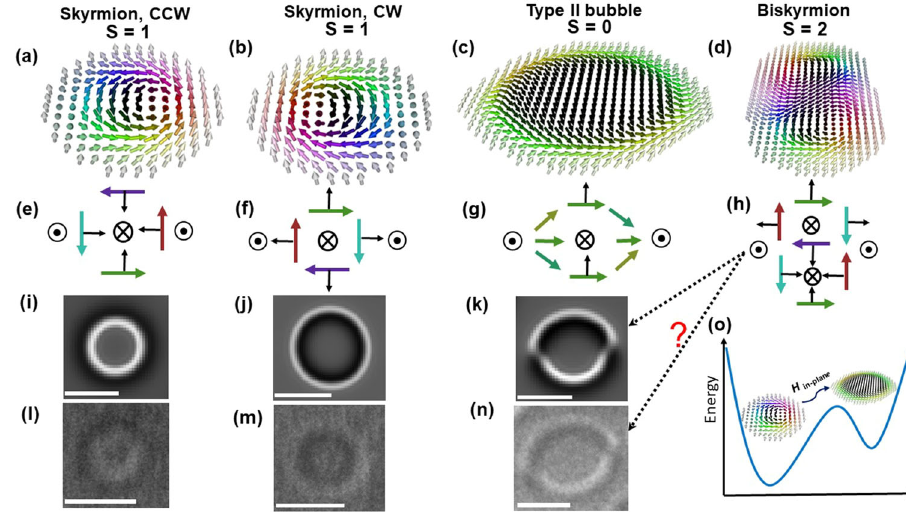
Fig. 1 Different types of skyrmion-like spin textures in centrosymmetric magnets. Magnetic spin texture of ( a ) skyrmion with counter-clockwise (CCW) helicity, ( b ) skyrmion with clockwise (CW) helicity, ( c ) type-II bubble, and ( d ) biskyrmion. e – h Schematics of the arrangement of in-plane magnetization components for the spin textures corresponding to ( a – d ), respectively. The black solid arrows in ( e – h ) represent the possible direction of electron de fl ection in Lorentz transmission electron microscopy (LTEM). i – k The LTEM simulated images corresponding to the schematics in ( e – g ). l – n Experimental LTEM images of the simulated LTEM pattern in ( e – g ). The dotted black arrows from ( h ) to ( k ) and ( n ) point that the biskyrmion spin structure can also give rise to the same kind of LTEM contrast to that of type-II bubble. Scale bars shown in the images ( i – n ) correspond 100 nm. o Schematic diagram showing that both skyrmion and type-II bubble can exist in a material with skyrmion being the lowest energy state. Application of a small in-plane magnetic fi eld can destabilize the skyrmion and nucleate type-II bubble as the system lacks any particular